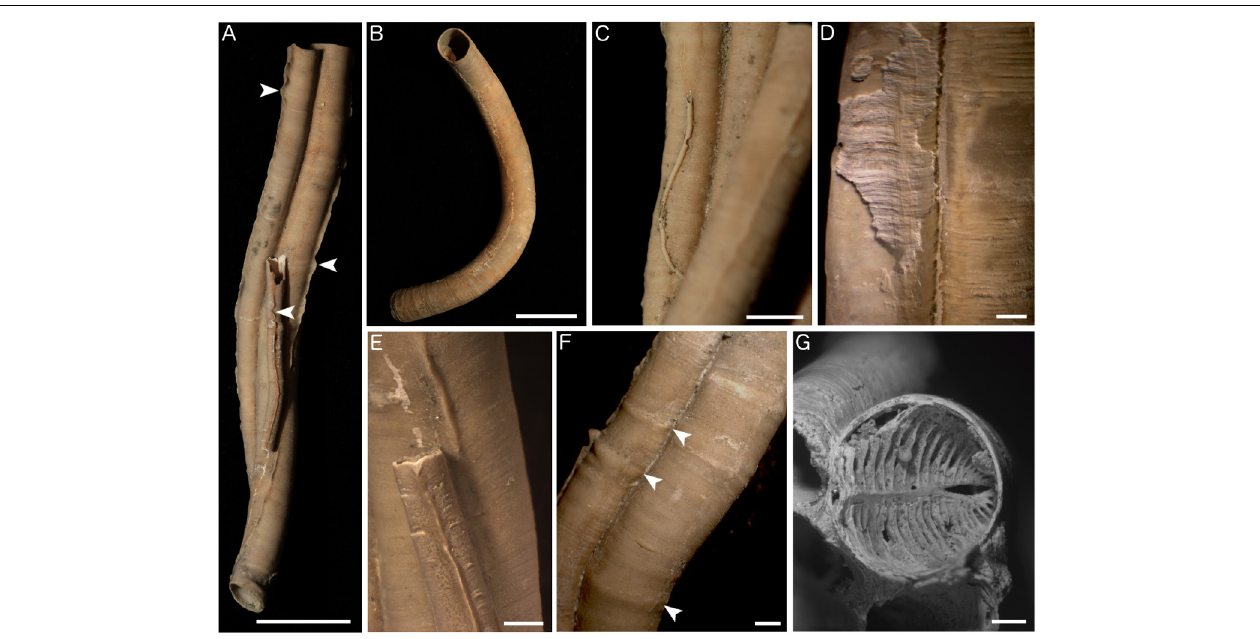
FIGURE 7 | Morphology of Fossil Hill serpulid tubes. (A) Several attached tube fragments with keels (white arrows) showing gregarious growth, sample DR476 A-1, and scale bar is 10 mm. (B) Curved nature of some of the fragments, sample DR629 PSC-52, and scale bar is 10 mm. (C) Small tube attached to larger tube, sample DR626 PSC-66, and scale bar is 2 mm. (D) Detail of transverse wrinkles apparent on some outer tube surfaces which are also present in the tube layer beneath the outermost, sample DR476 A-1, and scale bar is 1 mm. (E) Detail of tube keels, sample DR476 A-1, and scale bar is 1 mm. (F) Detail of peristomes occasionally present on the tubes (white arrows), sample DR476 A-1, and scale bar is 1 mm. (G) Detail of a tabula inside one of the tubes, sample DR476 A-1, and scale bar is 1 mm.